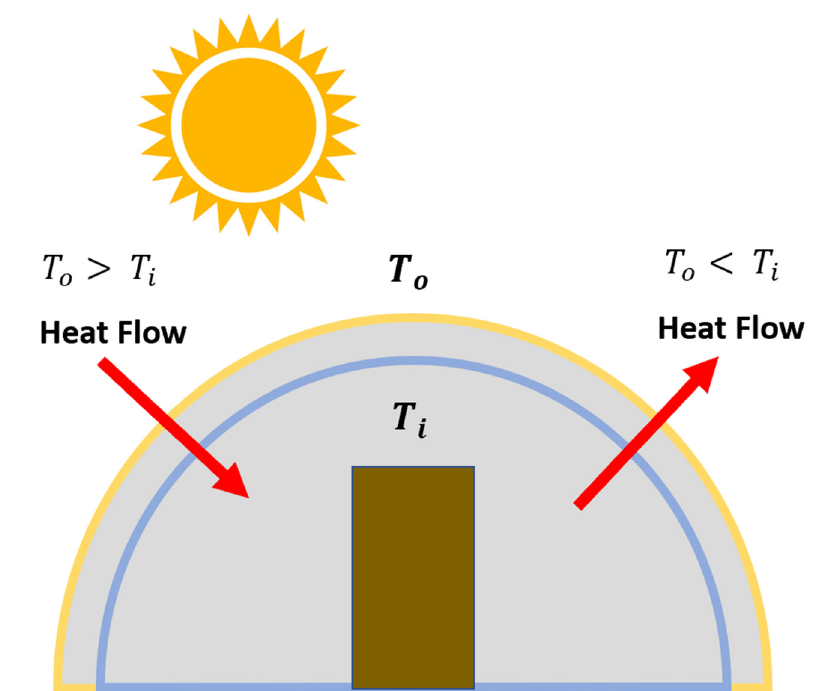
Figure 4. Visualization of the resistance to heat flow. T o and T i represent the exterior ambient temperature and interior temperature, respectively.